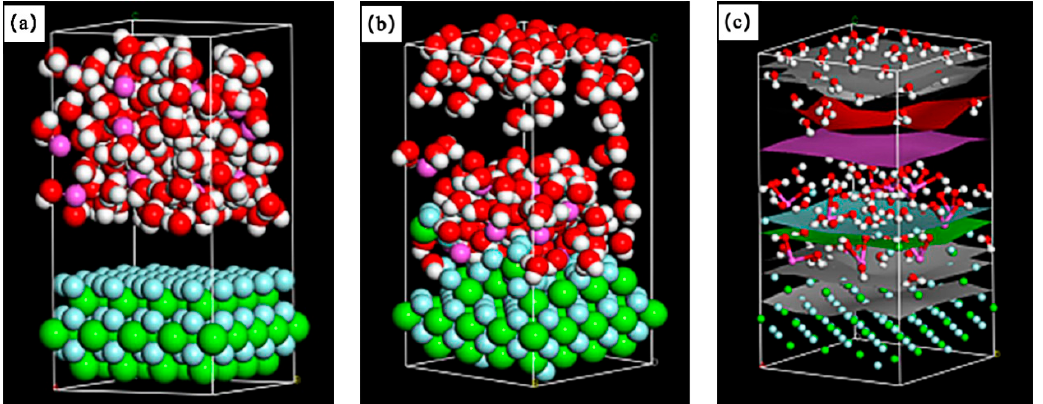
Figure 4. Model: ( a ) the model of CaF 2 surface; ( b ) the model of an aqueous solution containing Al(OH) 3 molecules.